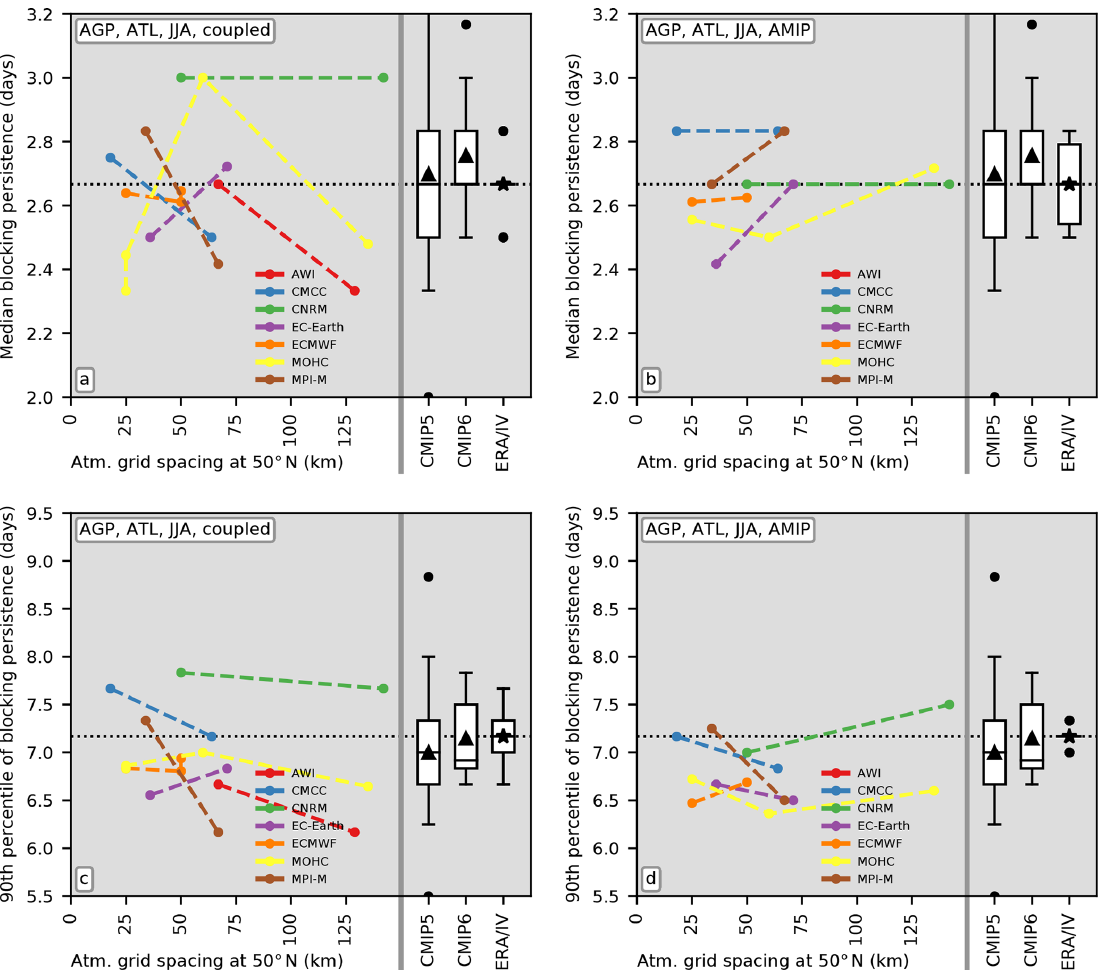
Figure 6. As Fig. 5 but for boreal summer. Persistence of blocking events ( a, b – median, c, d – 90th percentile) for the AGP index and for the ATL domain (50–75 ◦ N, − 90–90 ◦ E). The left-hand side of each panel shows metrics for PRIMAVERA simulations at different grid spacings (resolutions). Boxplots on the right-hand side show distributions of the persistence metric across CMIP5 and CMIP6 simulations. The “ ∗ ” symbol in the column “ERA/IV” shows the reanalysis estimate, and the boxplot is an estimate of the expected agreement given internal variability (see